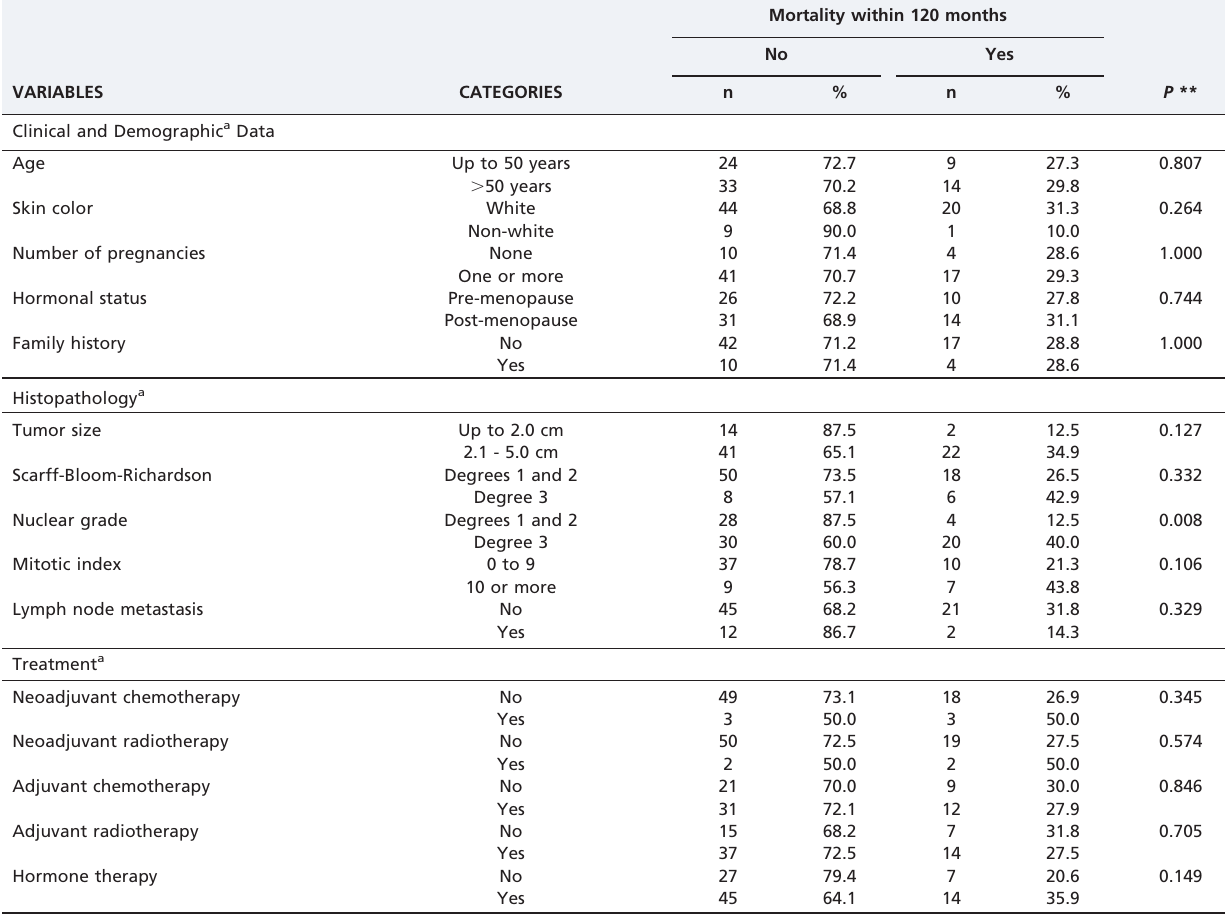
Table 2 - Case distribution according to clinical and demographic variables, histopathologic variables, treatment forms and mortality within 120 months of follow-up a among women with stage IIA tumors (n=